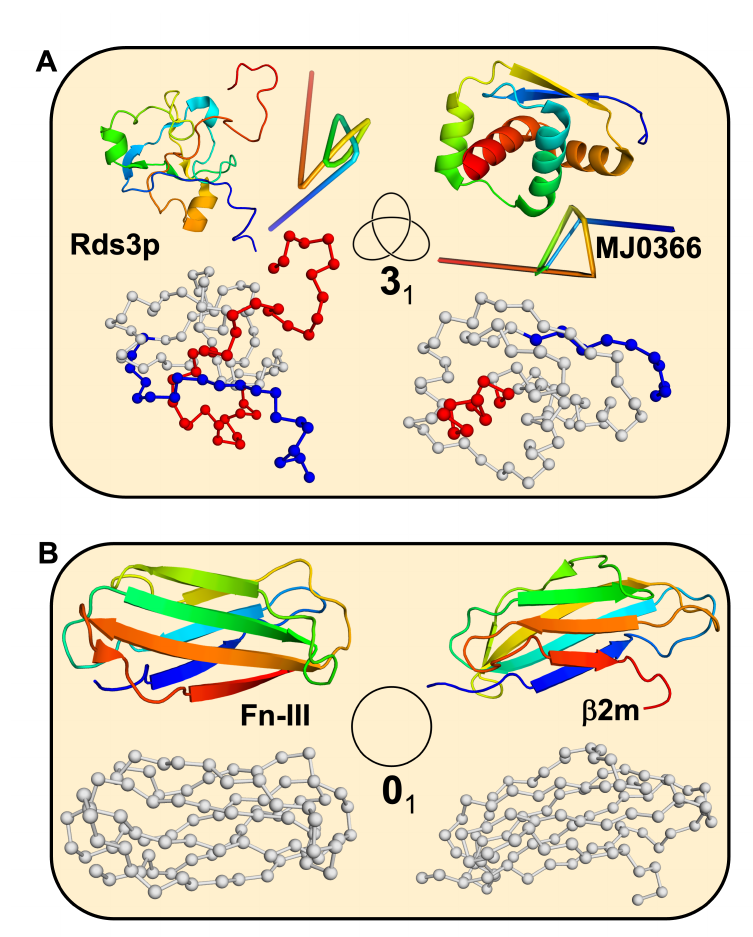
Figure 1. Model systems. ( A ) Knotted proteins: Rds3p (PDB id: 2K0A), MJ0366 (PDB id: 2EFV); residues in the N-tail are colored blue, residues in the knotted core are colored grey, and residues in the C-tail are colored red; reduced representations of the knots obtained from the protein knots server [35]. ( B ) Unknotted proteins: Fn-III (PDB id: 1TEN), β 2m (PDB id: